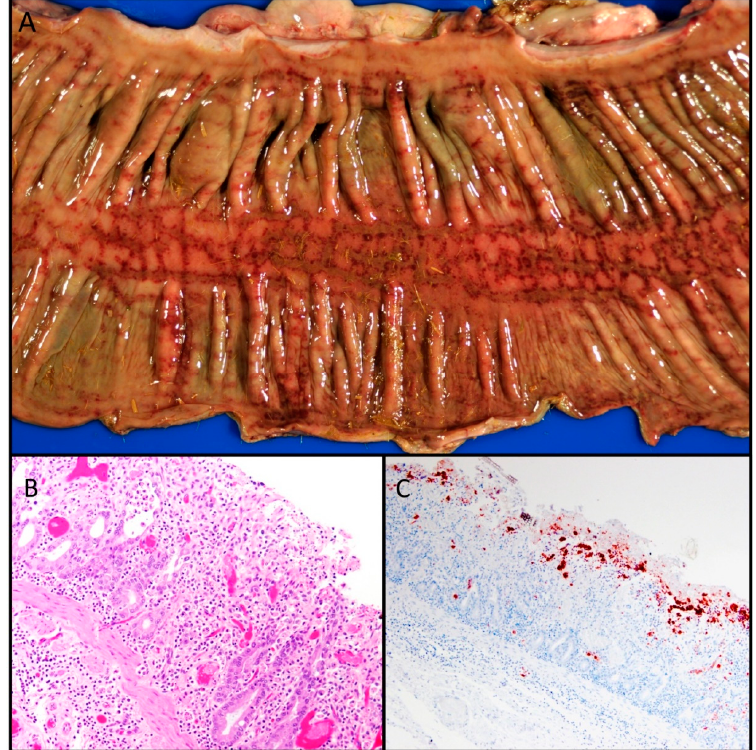
Figure 5. ( A ) Equine coronavirus-associated colitis, colon, horse. Moderate, necrohemorrhagic colitis. Image courtesy of Silvia Siso. ( B ) Equine coronavirus-associated enteritis, jejunum, horse. Mixed inflammatory enteritis with crypt ectasia and necrosis (crypt “abscesses”) and microvascular thrombi. ( C ) Equine coronavirus-associated enteritis, jejunum, horse. Diffuse immunoreactivity at the tips of necrotic villi using bovine coronavirus antiserum (immunohistochemistry). Images 5B and 5C courtesy of Federico Giannitti.